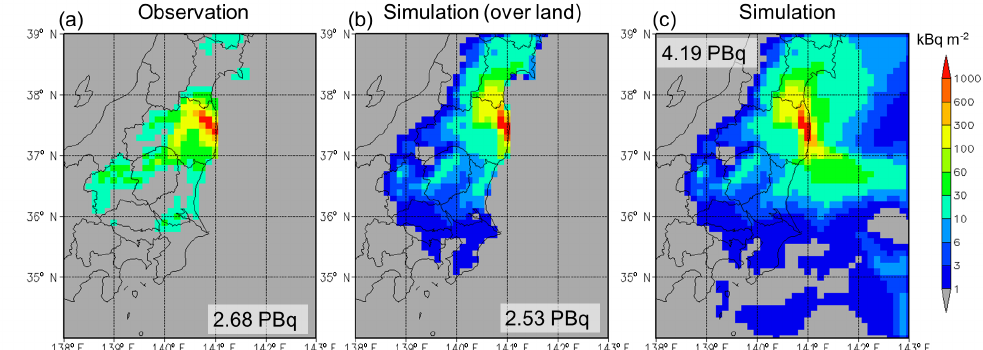
Figure 4. (a) Aircraft observation and (b, c) simulation of 137 Cs deposition depicted (b) only over land and (c) for the whole domain (kBqm − 2 ) . The observation was interpolated to the model grid ( (cid:49) longitude = 0.125 ◦ and (cid:49) latitude = 0.1 ◦ ). A decay correction for the observation was made for March–May 2012, varying depending on the region. The simulation provided a cumulative value from 12 March to 1 April 2011. The total activities are presented as numbers. The color scales are the same for (a) – (c) but observed values are not depicted below the detection limit, 10kBqm − 2 . The deposition parameters of the simulation in the figure are E c = 0.04 and v d = 0.1cms − 1 .